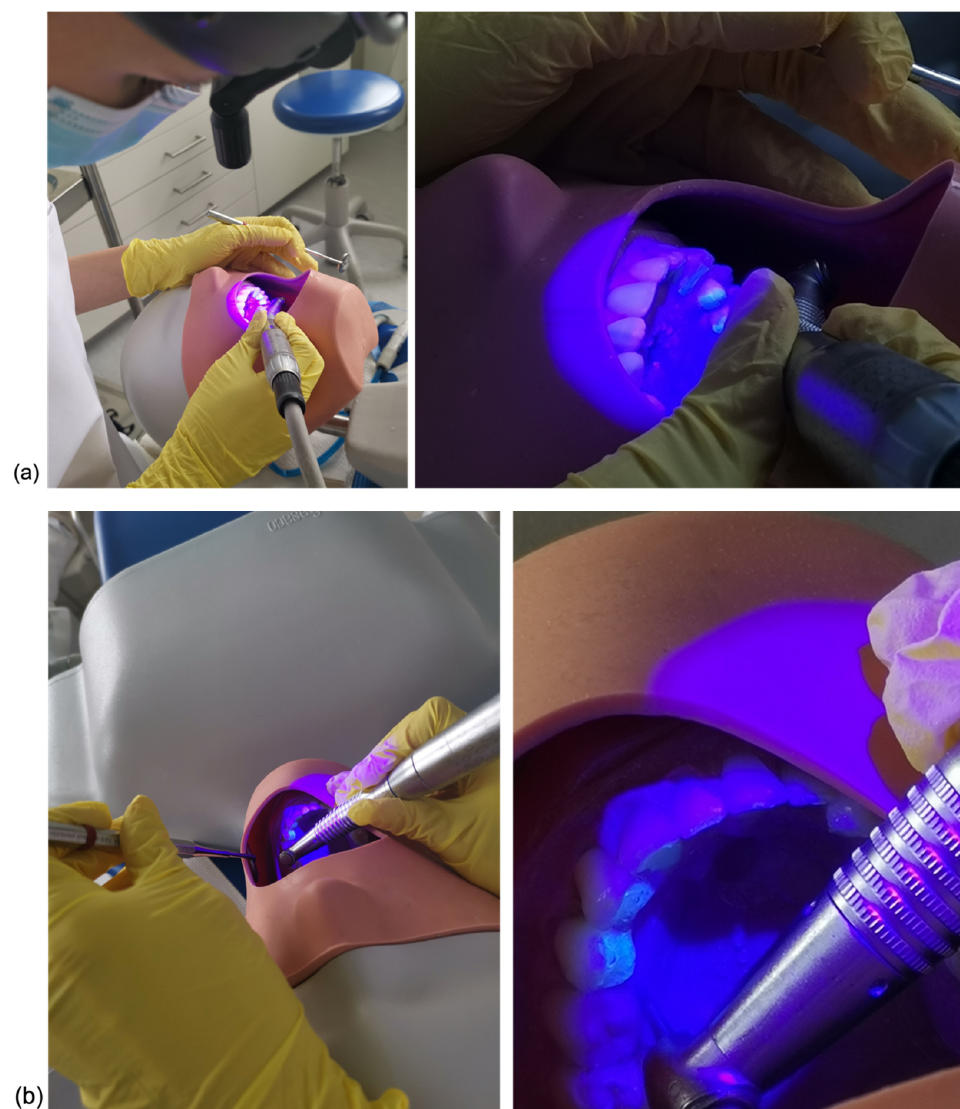
Figure 4. Clinical set-up for surface clean-up on the upper ( a ) and lower ( b ) dental arches.